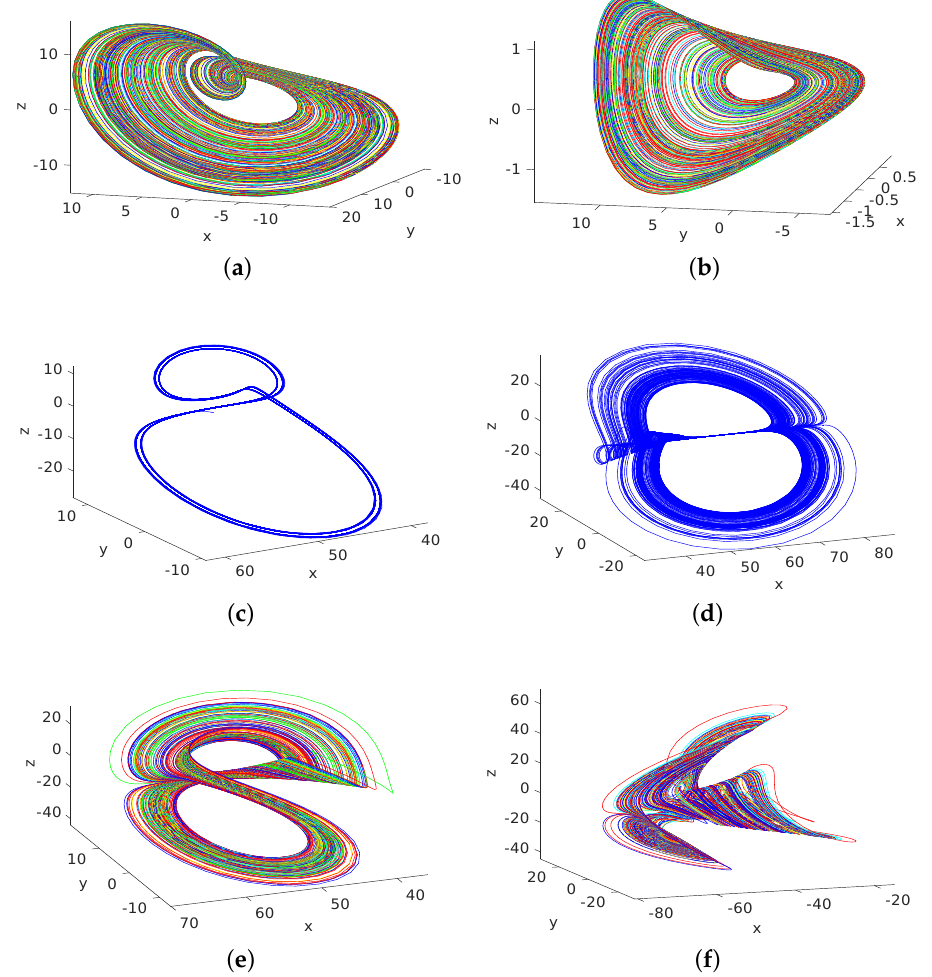
Figure 9. The phase portrait of system (1) with different parameter values: ( a ) a = 5.8, b = 9, c = 15, d = 11; ( b ) a = 0.4, b = 60, c = 10, d = 10; ( c ) a = 5, b = 50, c = − 6, d = 25.5; ( d ) a = 5, b = 60, c = − 6, d = 34; ( e ) a = 5, b = 55, c = − 6, d = 16; ( f ) a = 16, b = − 60, c = 3, d =